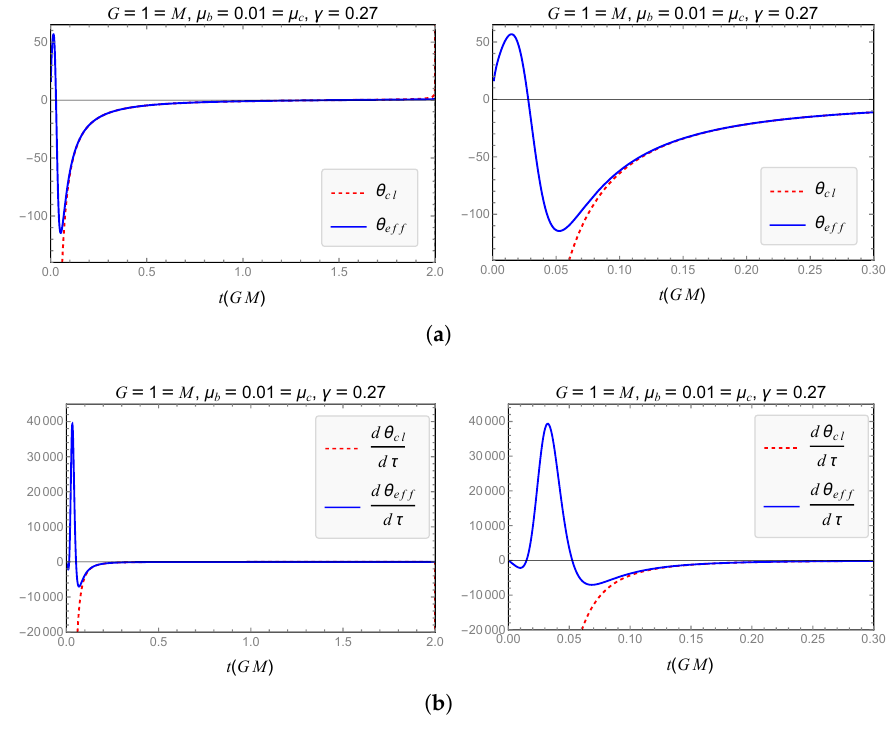
d θ TL ( ˚ µ ) Figure 4. θ TL and . ( a ) Left: Classical vs. timlike θ in the ˚ µ scheme as a function of the ( ˚ µ ) d τ Schwarzschild time t . The effective expansion θ TL goes to zero as t → 0. Right: Close up of the ( ˚ µ ) left figure close to t = 0. ( b ) Left: Classical vs. timlike d θ in the ˚ µ scheme as a function of the d τ d θ TL ( ˚ µ ) Schwarzschild time t . The effective goes to zero as t → 0. Right: Close up of the left figure close d τ to t =